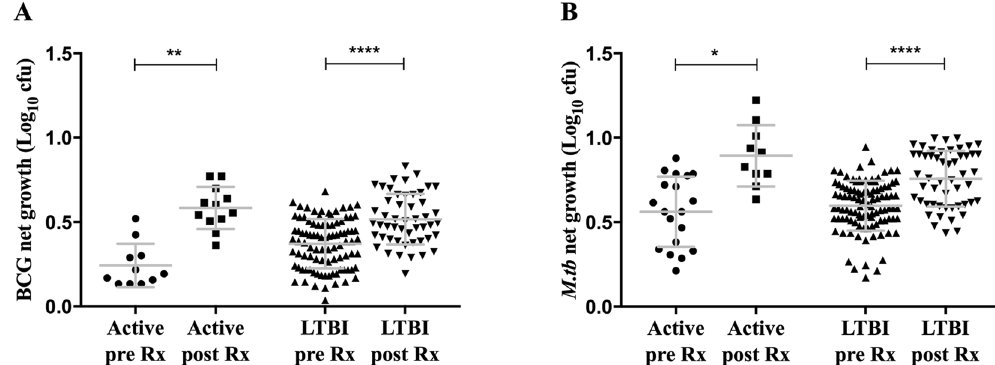
Figure 2. Enhanced mycobacterial control decreases following TB treatment. Samples were collected from volunteers with active TB and LTBI between 1 to 6 months following completion of anti-TB treatment. Whole blood MGIT using BCG Pasteur ( A ) and M . tb H37Rv ( B ) was performed. Data meeting the inclusion criteria (duplicate Δ TTP < 6 hours) are shown. For MGIT data, points represent the mean of duplicates; bars represent mean values with SD. A paired t- test was performed to assess net growth before and after treatment. * Represents a p-value of < 0.05, ** a p-value of < 0.01 and **** a p-value of < 0.0001. Red circles = active TB and black =